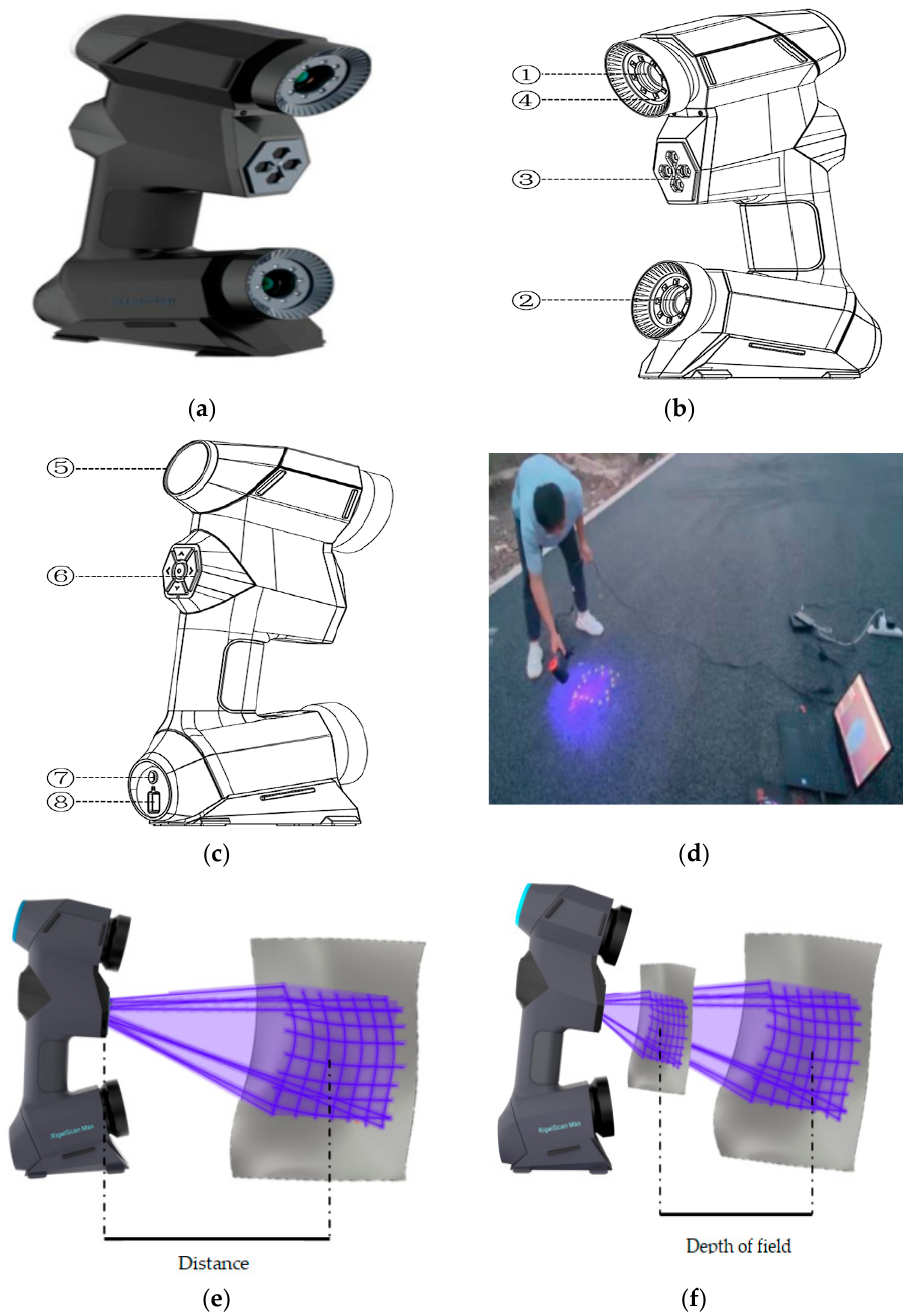
Figure 2. ( a ) Three-dimensional topography instrument; ( b ) ① camera A; ② camera B; ③ transmi tt er optical; ④ LED light supplement lamp; ( c ) ⑤ ring coloured indicator; ⑥ function bu tt ons; ⑦ power plug; ⑧ socket transfer data; ( d ) pavement scanning; ( e ) scanning distance; ( f ) depth of fi eld distance. The instrument has 28 crossed blue laser lines, which can carry out fast scanning in